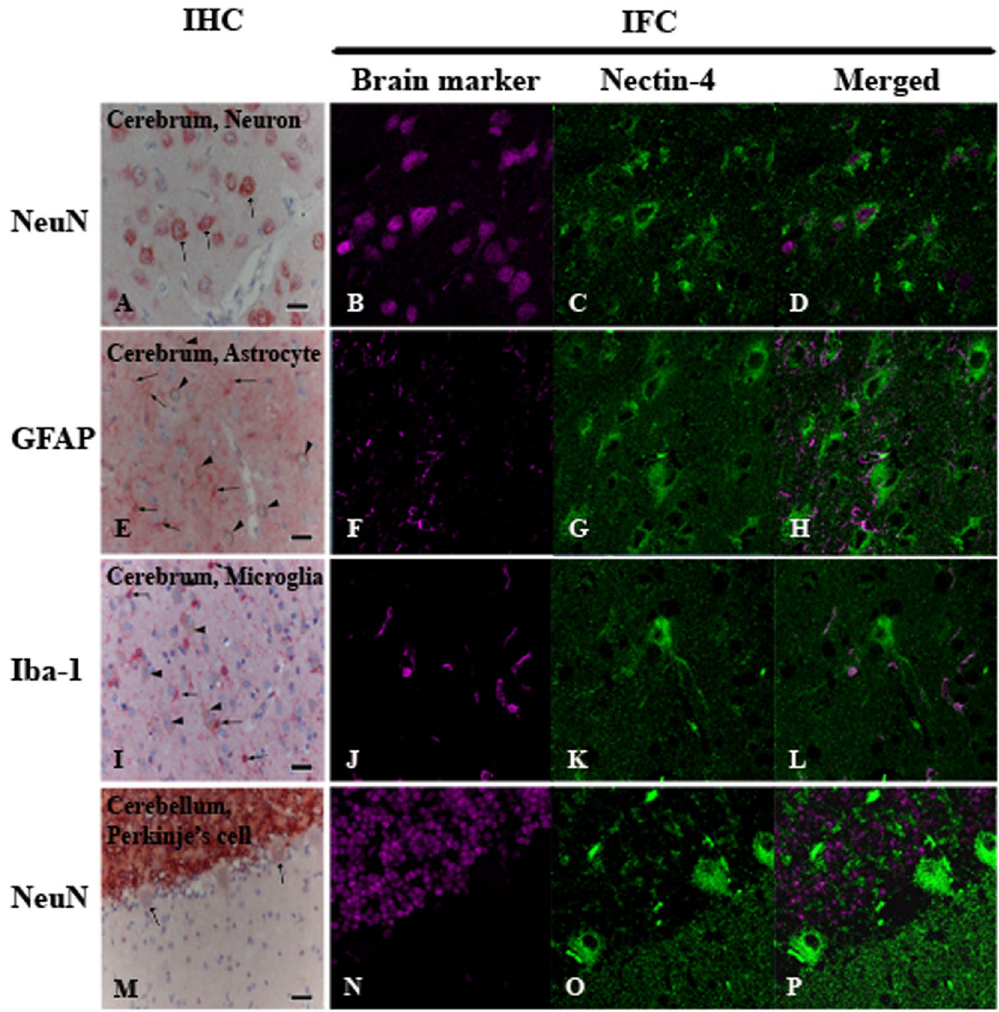
Figure 2. Immunohistochemistry (IHC) and immunofluorescence assay (IFA) of nectin-4 expression in normal canine brain. Nectin-4 was stained in brown (IHC) and in green (IFA) while brain markers (NeuN, GFAP, Iba-1) was labeled in red (IHC) and in magenta (IFA). Merged panel of IFA revealed the co-localization of both antigens in particular cells. Neurons at cerebrum predominately co-expressed nectin-4 and NeuN ( A – D , arrows). Astrocytes at cerebrum were stained with GFAP ( E , arrows), not nectin-4 ( E , arrow heads indicated neurons). Microglia at cerebrum were separately immunolabeled with Iba-1 ( I , arrows) and nectin-4 ( I , arrow heads indicated neurons). Purkinje’s cells at cerebellum showed weakly nectin-4 positive ( M , arrows) without NeuN staining. (IHC, Bar = 20 μ m; IFA, 4,000 fold